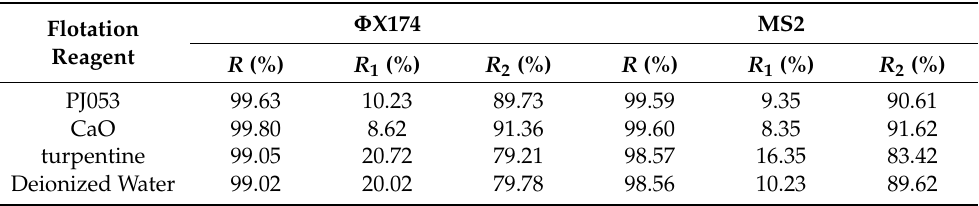
Table 5. Virus removal and recovery in the presence of flotation